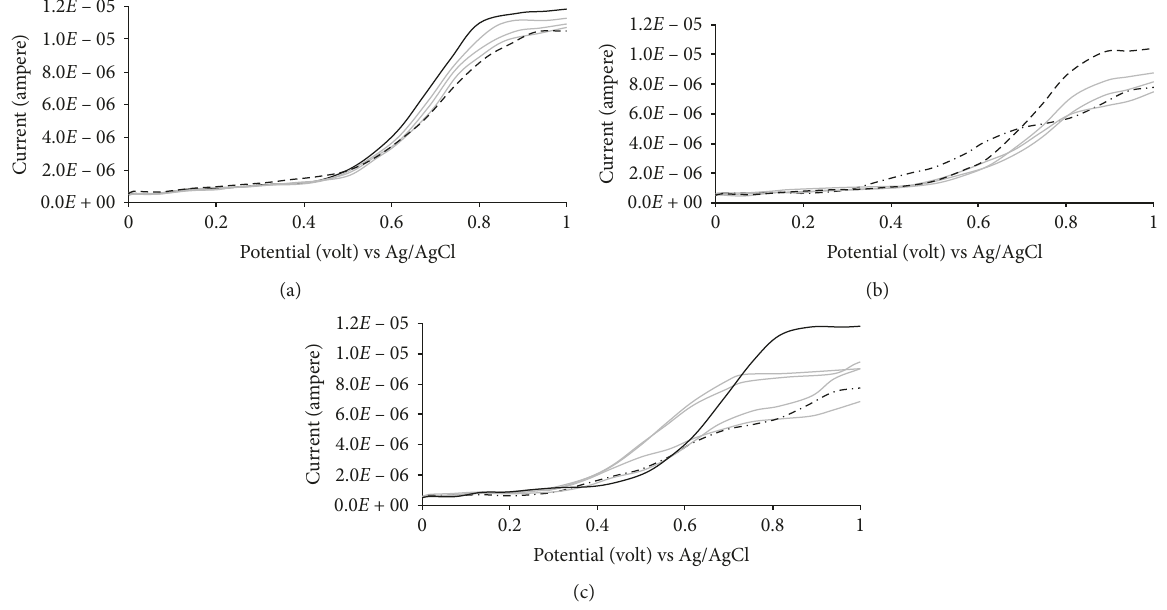
Figure 1: Square wave voltammograms of extracts for CE: (a) lemon and blueberry; (b) blueberry and grape; (c) lemon and grape. Lemon , blueberry , and grape . The gray lines represent the binary mixtures in different ratios of fruit (25/75, 50/50, and 75/25 w/w).